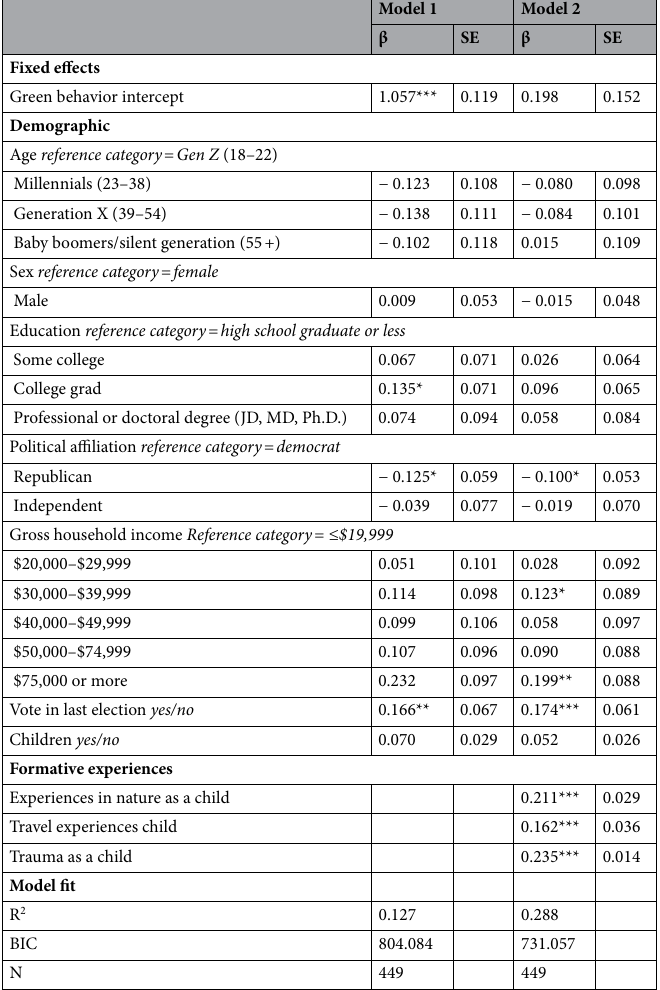
Table 3. Regression predicting green behavior. β standardized beta coefficients, SE standard error. *p < 0.05, **p < 0.01, ***p <